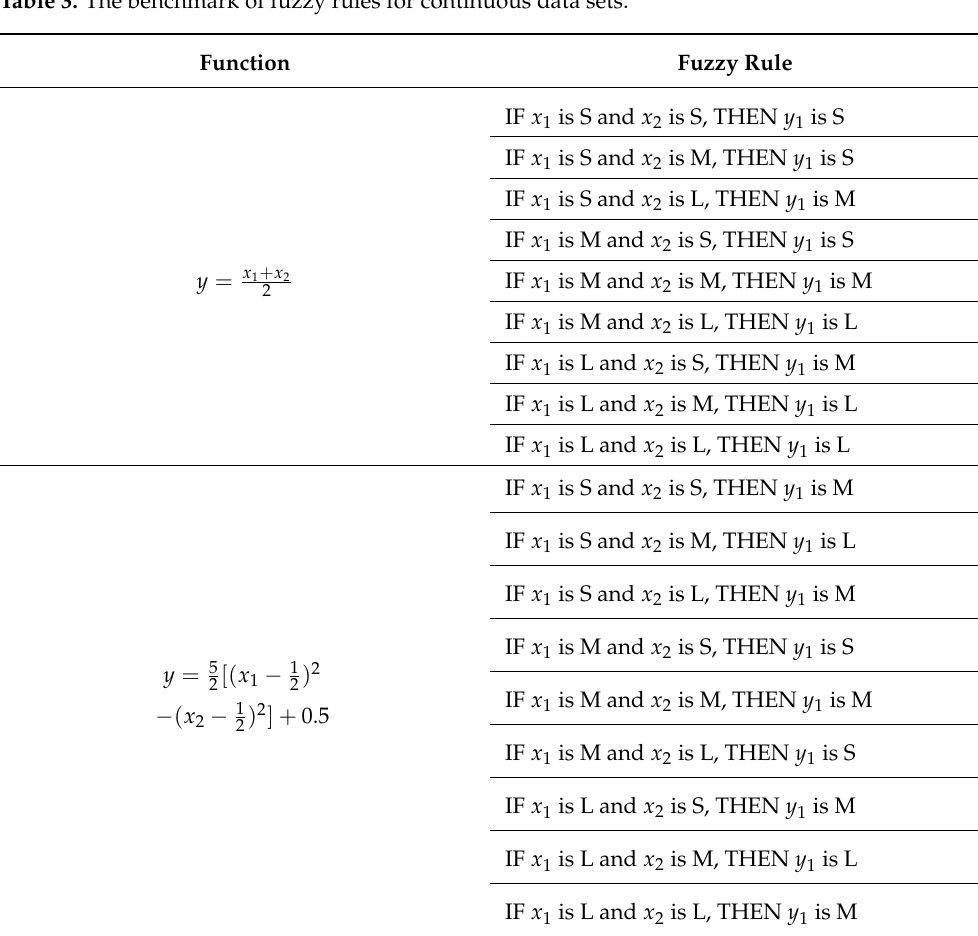
Table 3. The benchmark of fuzzy rules for continuous data